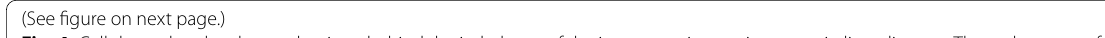
figure on next Fig. 4 Cellular and molecular mechanisms behind the imbalance of the immune microenvironment in liver diseases. The early stages of ( a ) cirrhosis are characterized by a vicious cycle of liver inflammation, liver damage and fibrosis, whereas the advanced stages are characterized by immunodeficiency. Immunocompromised liver diseases include ( b ) CVH and ( c ) HCC, which have immunocompromised hepatic innate and adaptive immune cells resulting in impaired immune surveillance against viruses and